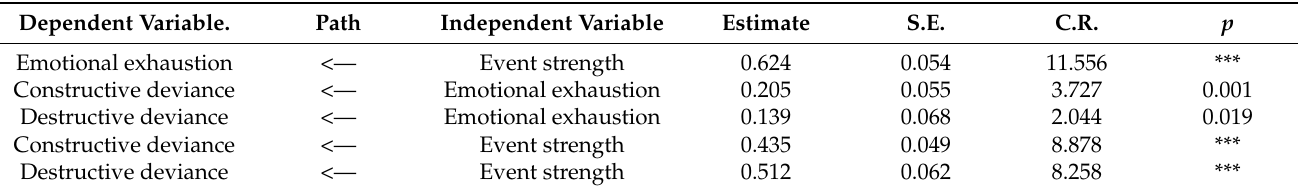
Table 5. Mediating effect